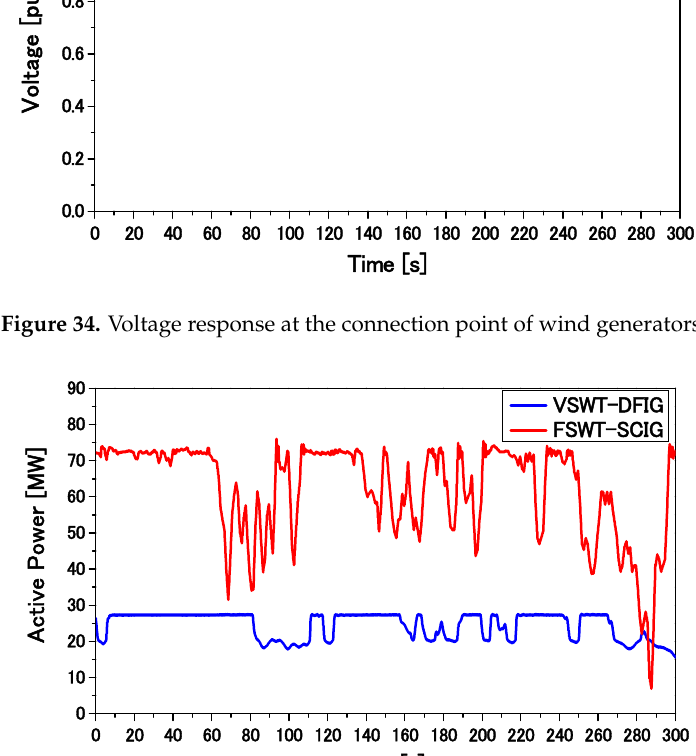
Figure 35. Active power output of wind generators.